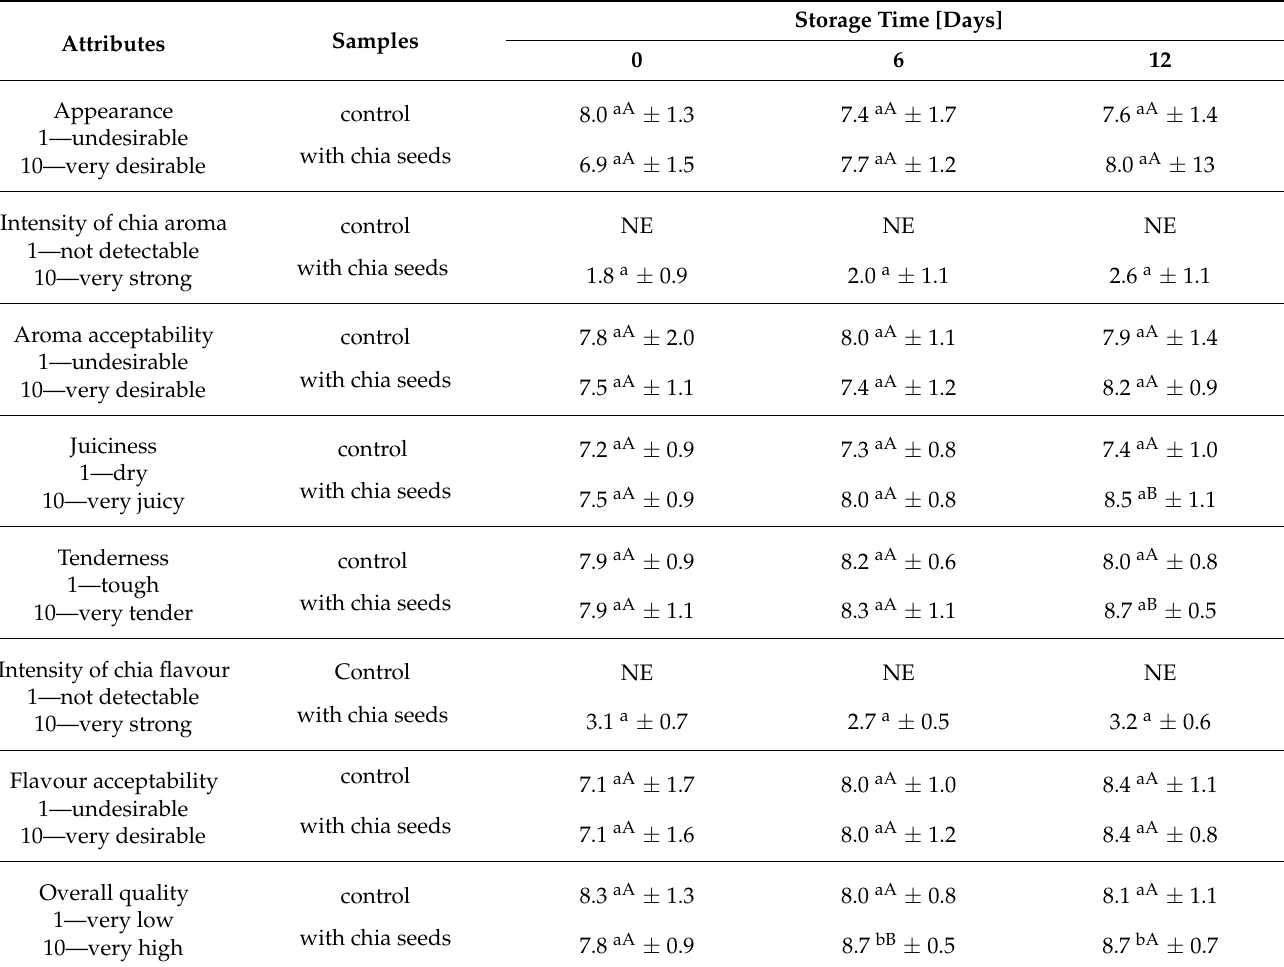
Table 5. Effect of chia seeds and storage time on the sensory quality of pork patties (mean ±